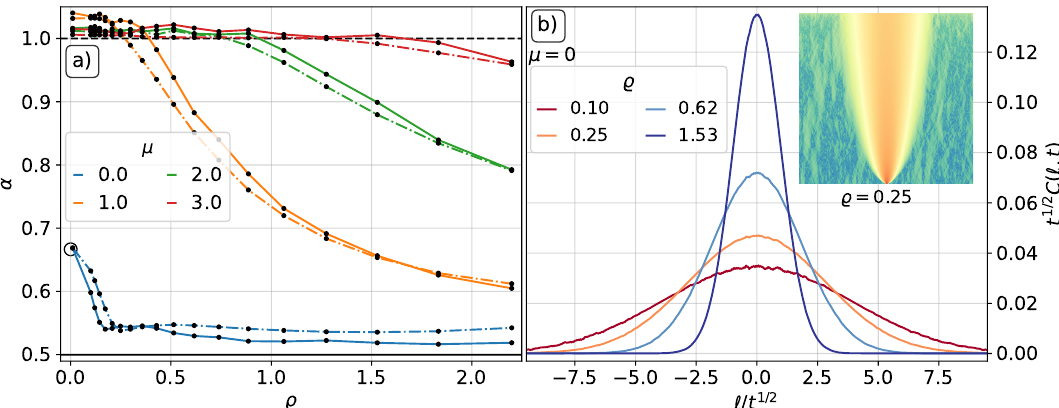
Figure 5: (a) Finite-time dynamical exponents α ( t ∈ [ 100,300 ] dashed-dotted lines, t ∈ [ 300,1000 ] solid lines) depending on the anisotropy (cid:37) at four values of the chem- ical potentials µ . Magnetized ensembles ( µ > 0) exhibit ballistic transport with expo- nent α = 1. The sub-leading diffusive correction increases with (cid:37) and overwhelms the ballistic contribution at finite times. In the non-magnetized sector at µ = 0, the dynamical exponent is approximately α ≈ 2 / 3 (black circle) when approaching (cid:37) → 0, consistent with KPZ-type superdiffusion at the isotropic point (cid:37) = 0. At large values of (cid:37) , the dynamical exponent approaches α ≈ 1 / 2 which is indicative of normal diffusion. (b) Rescaled diffusive stationary scaling profiles of the dynamical structure factors t 1 / 2 C ( (cid:96) , t ) at µ = 0 and different values of (cid:37) . Simulation parame- ters: τ = 1, L = 2 12 , averaged over 10 5 initial configurations.